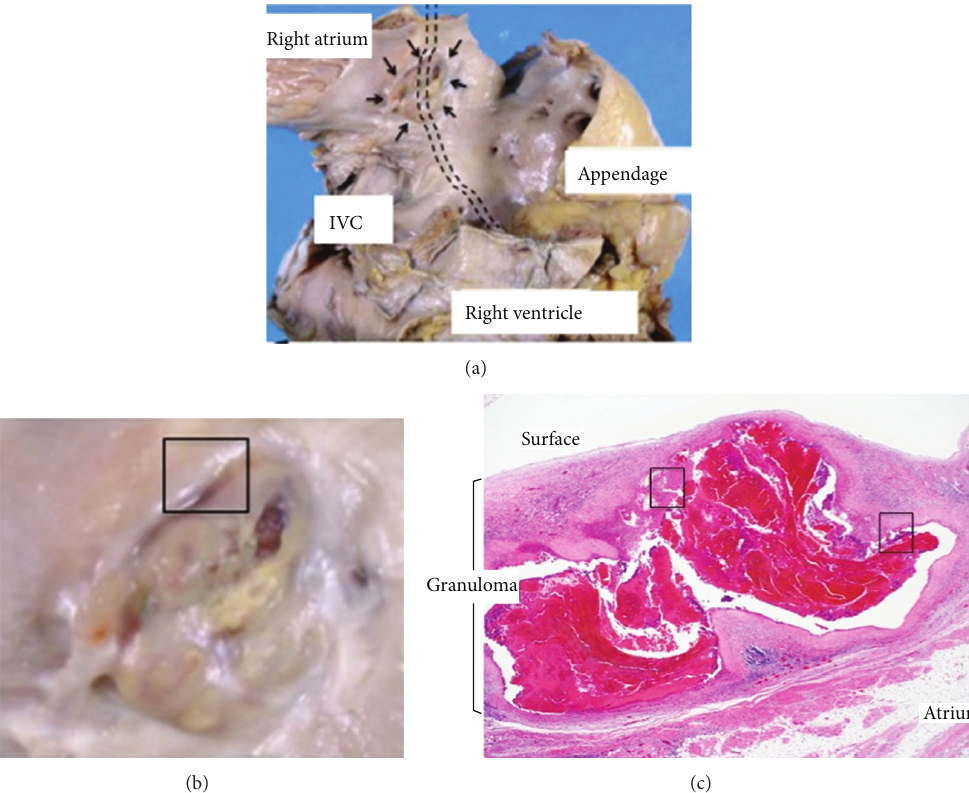
Figure 1: Macro-and microscopic findings. (a) At autopsy, the pacemaker lead was entrapped by a nodule. After detachment of the lead from the nodule, the base of the nodule was 1.5 × 1.0cm in size as shown by the arrows. The possible course of the lead was depicted by dotted lines. (b) The nodule had a broad basis on the endocardium of the right atrium. The edge was cut and used for microscopic examination (rectangle). (c) Histologically, the nodule revealed fibrosis, lymphocyte infiltration, small vessels, and hemorrhagic